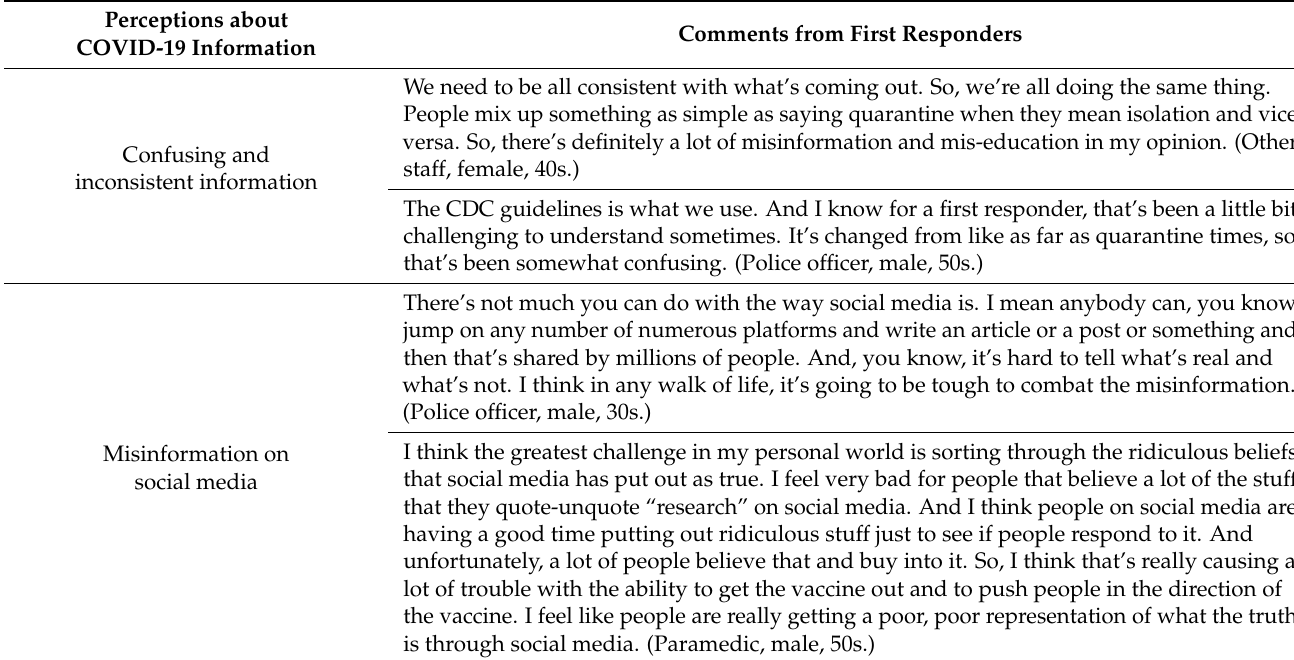
Table 4. Confusion around COVID-19